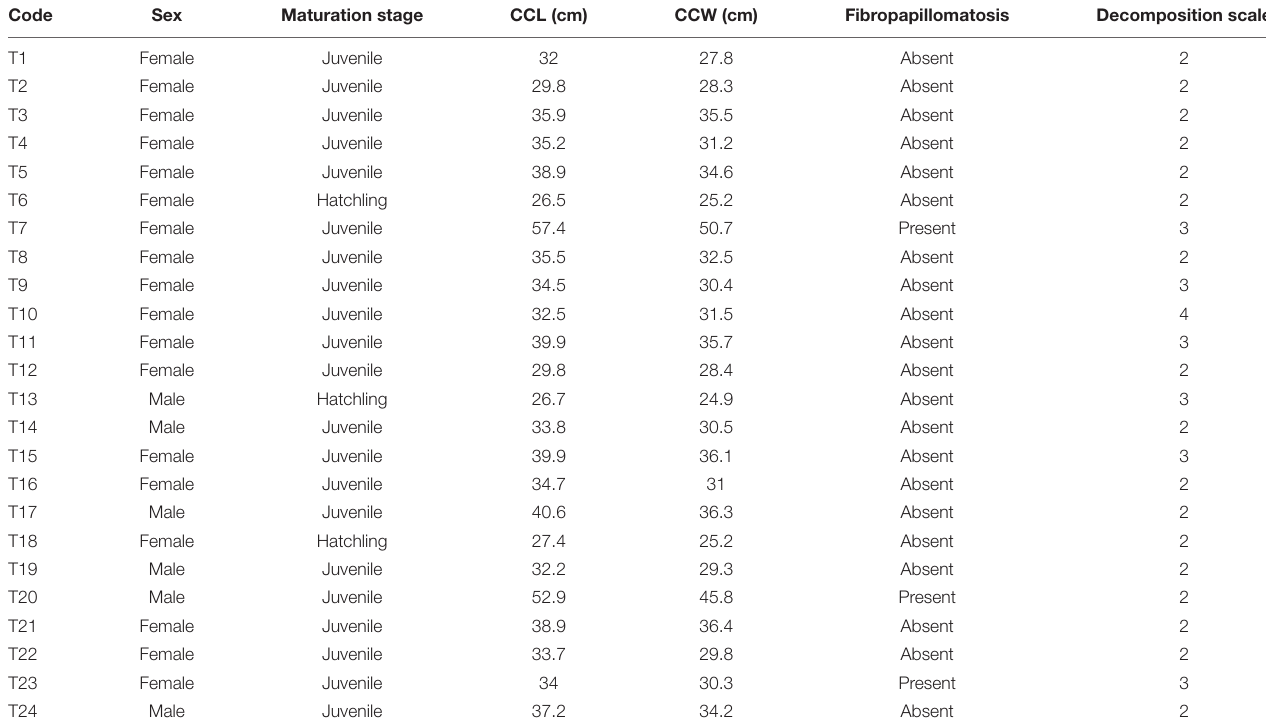
TABLE 4 | Morphobiometric results of the evaluated sea turtles, indicating, sex, maturation (according to CCL), curved carapace length (CCL, in cm), curved carapace width (CCW, in cm), and presence or absence of fibropapillomatosis. Code